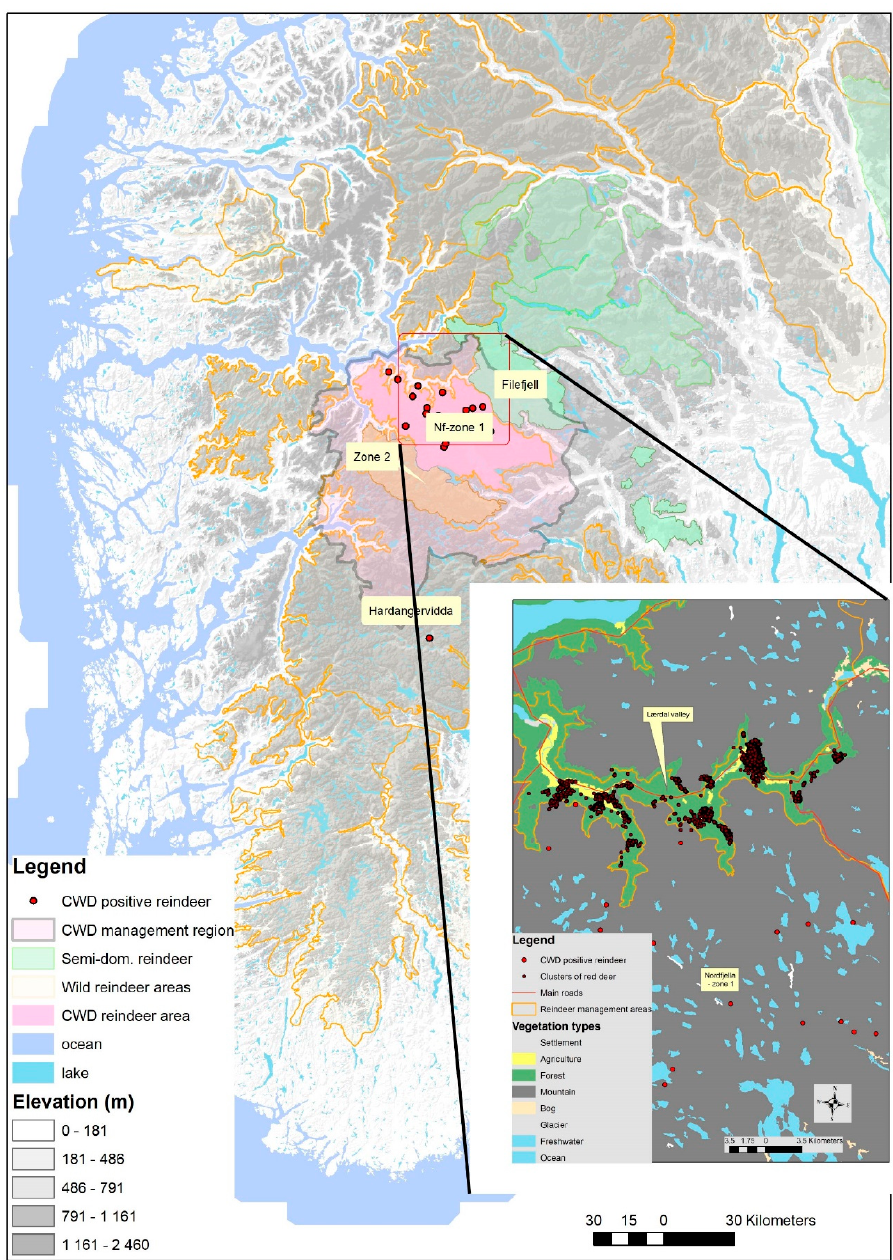
Figure 1. An overview of the study area in the Lærdal municipality in the Nordfjella region, Norway. (insert) Detailed positions of the winter clusters being visited in the field.